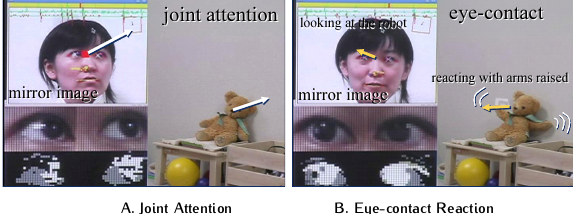
Figure 1. Stepwise Gaze-communication Model